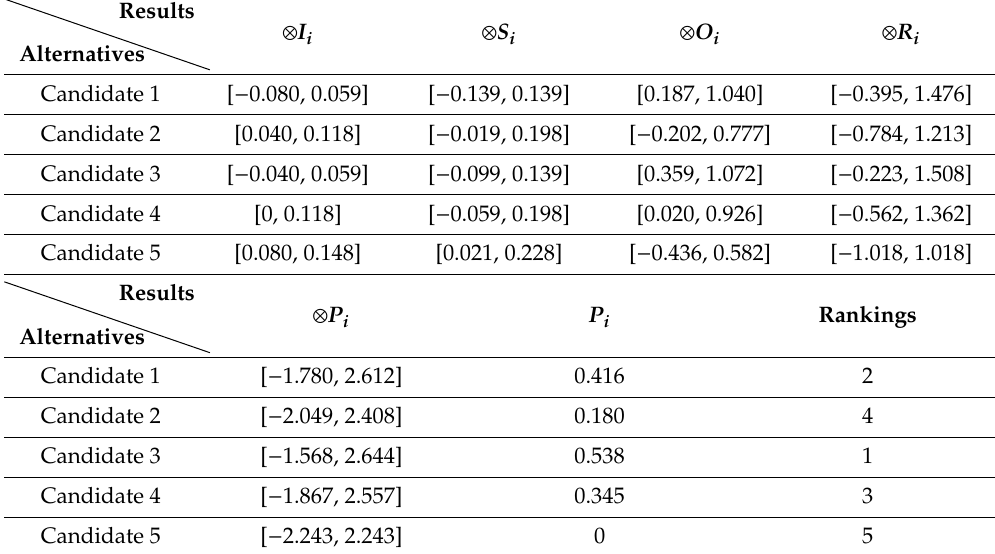
Table 10 accounts for the results of the OCRA-G method. Table 10. The results of